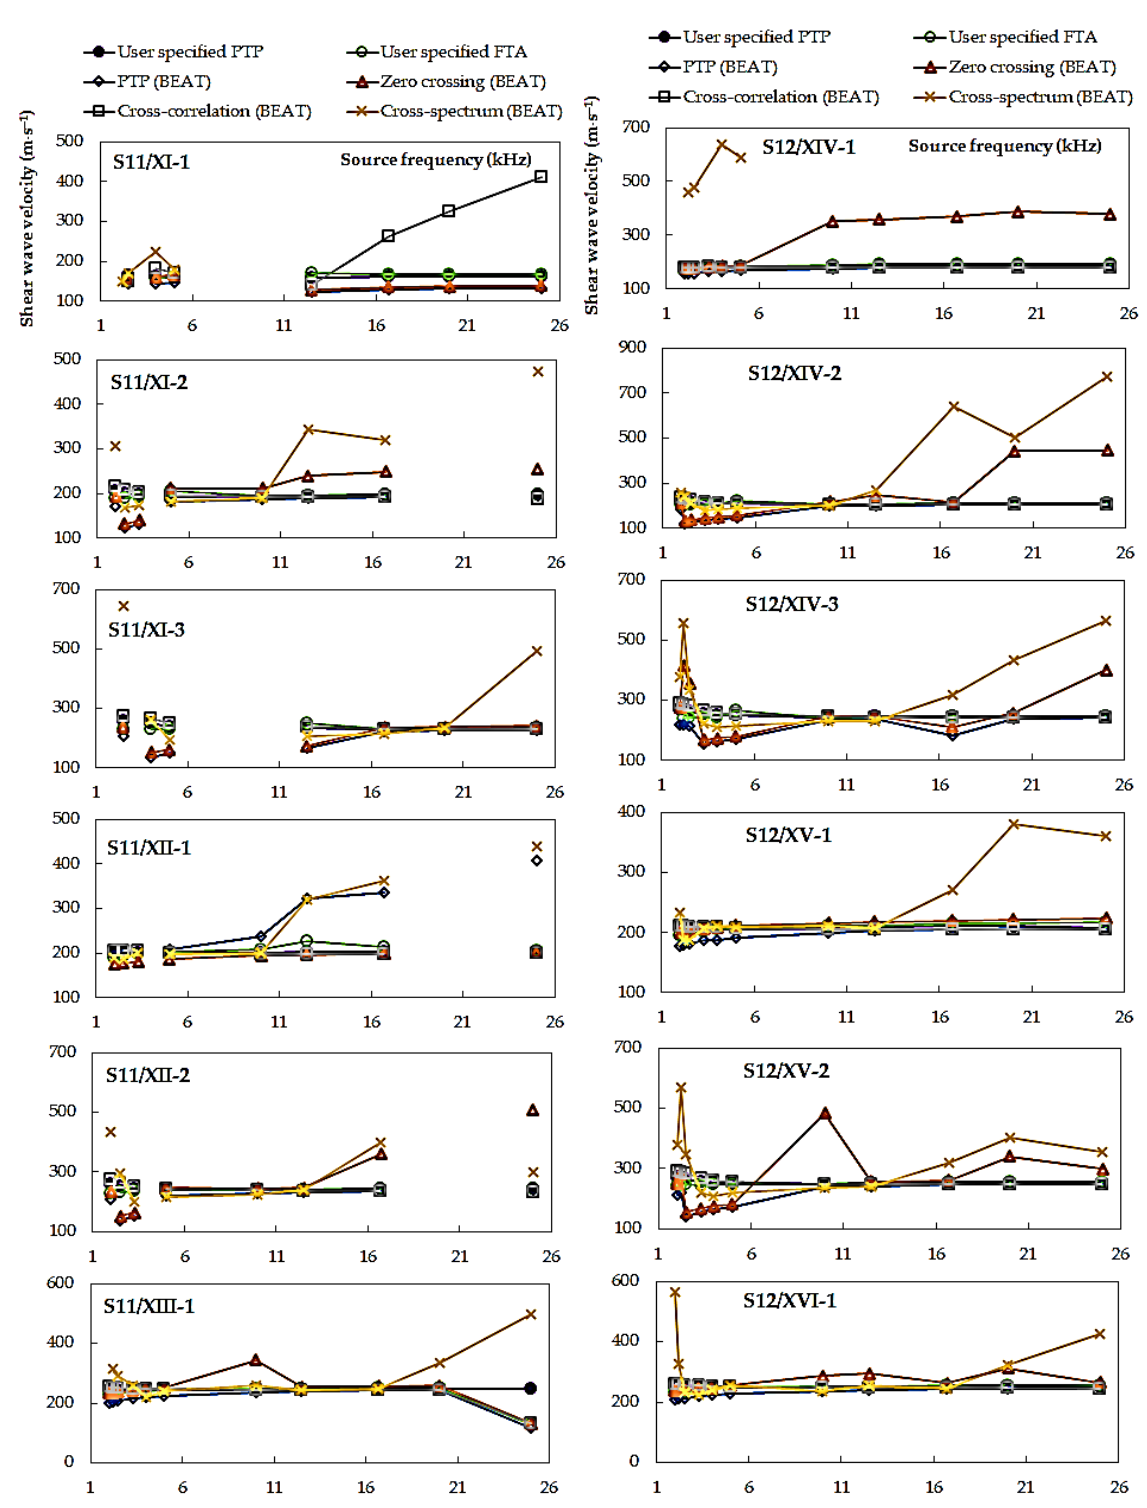
Figure 10. Shear wave velocities calculated from various methods of interpretation of BE test results, data for specimens S11–S12.